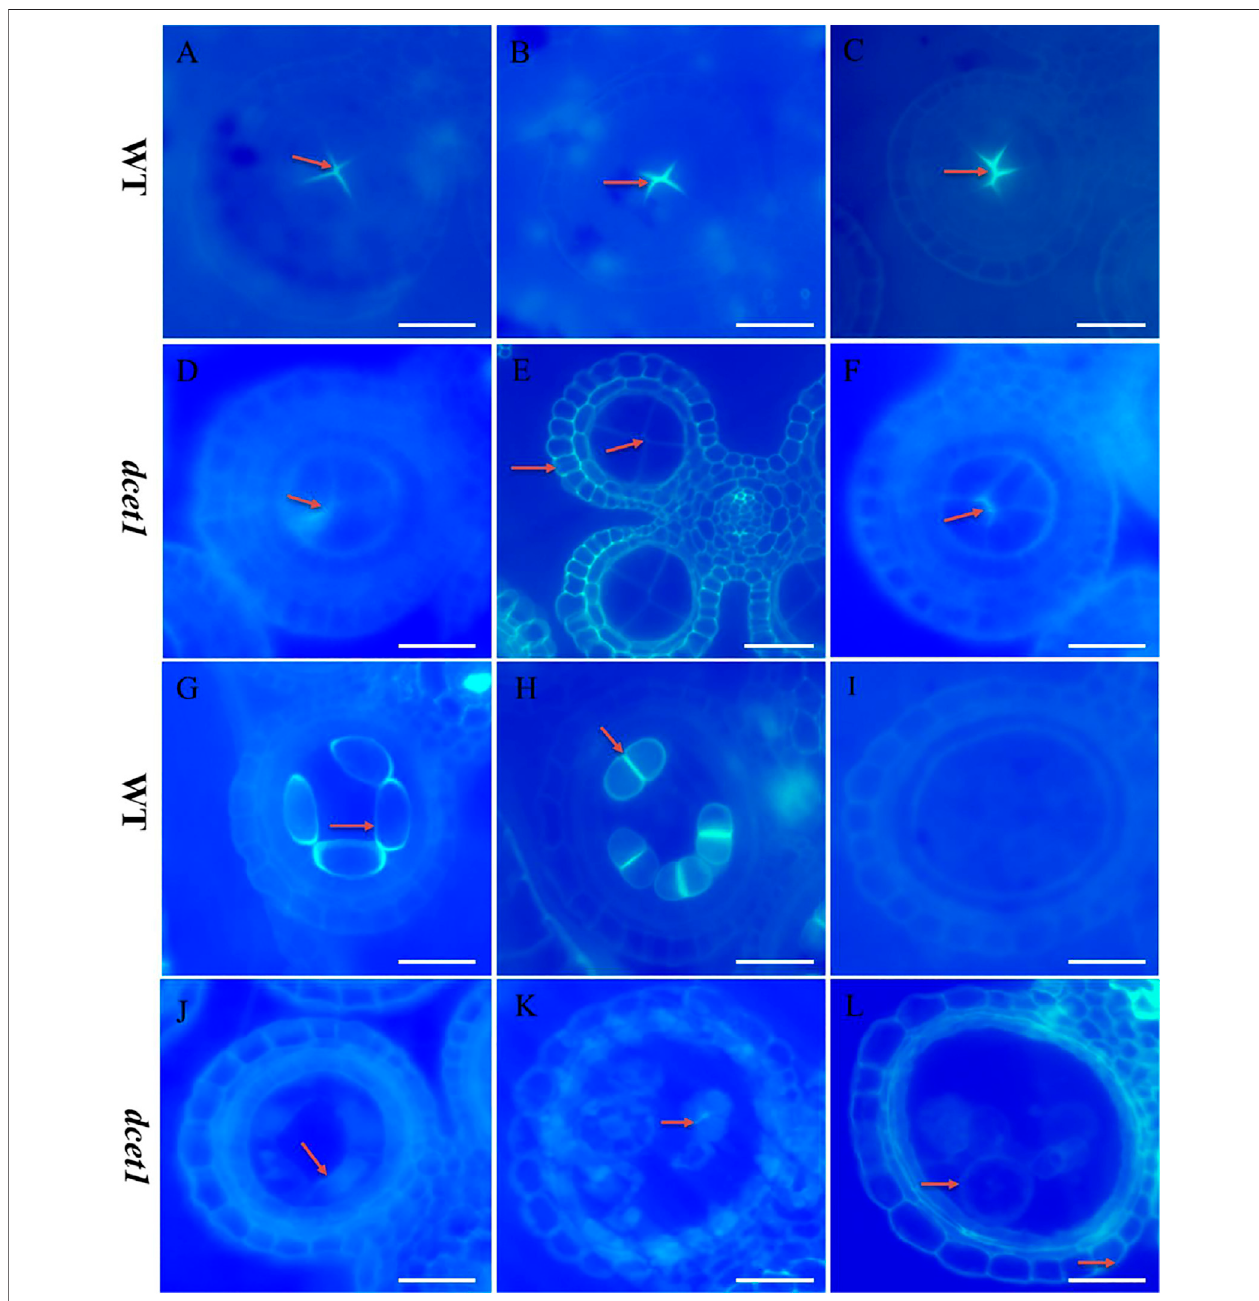
FIGURE6| Anther calloselayeranalysisofwild-type(WT), andmutant ( dcet1 ).Anilineblue stainingofWT (A – C,G – I) and dcet1 (D – F,J – L) foranther development stages 5, 6, 7, 8a, 8b, and 9, respectively, Red arrows highlight the callose layer. Scale bars (cid:1) 20 µm.